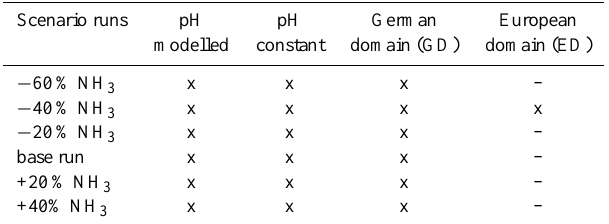
Table 3. Overview of performed ammonia emission sensitivity sce- nario runs and their